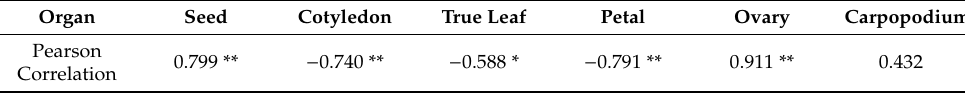
Table 8. Pearson Correlation among shape indexes of di ff erent